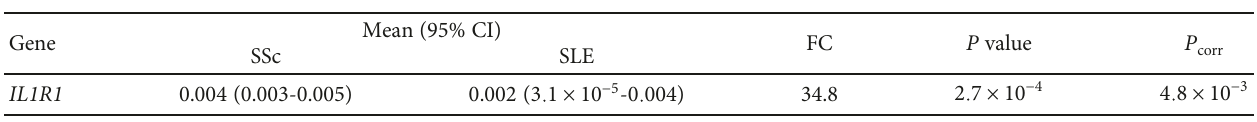
Table S1 (Integrated DNA Technologies, USA). The relative mRNA expression was calculated using phosphoglycerate kinase 1 as a reference gene [18].